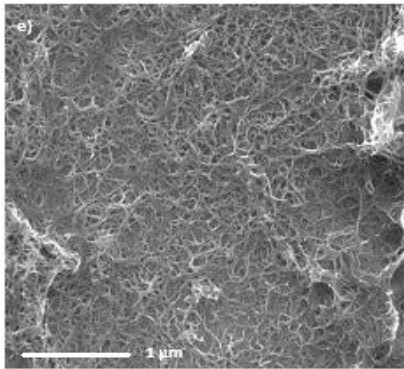
Figure 1. Scanning electron microscopy (SEM) images of various types of carbon nanotube (CNT) samples on Si: ( a ) single-walled carbon nanotube sample 1 (SWCNT-1); ( b ) single-walled carbon nanotube sample 2 (SWCNT-2); ( c ) double-walled carbon nanotube sample 1 (DWCNT-1); ( d ) DWCNT-2; and ( e ) multi-walled carbon nanotube (MWCNT).